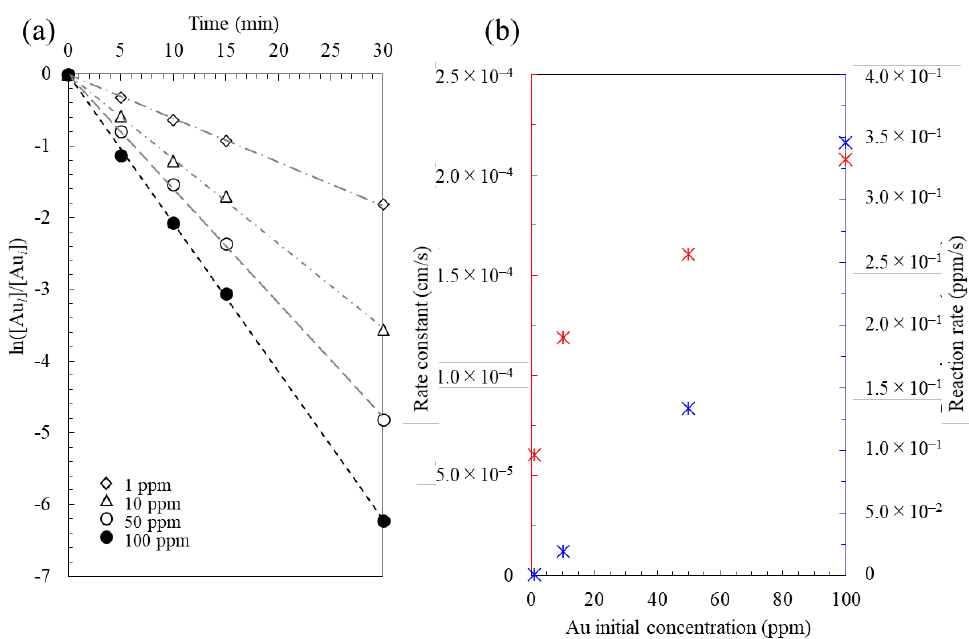
Figure 1. ( a ) The effects of initial Au concentration on the recovery of Au ions, and ( b ) the plot of rate constant/reaction rate vs. initial Au concentration for the cementation reaction by galvanic interaction of Al and AC in the ammonium thiosulfate system (Note that reaction rate has a minus value). Table 1. Summary of rate constant for the cementation of Au onto the Al as a function of initial Au concentration (base conditions: 10 mL solution containing 1 M of Na 2 S 2 O 3 , 0.5 M of NH 3 , 0.25 M of 25 °C).